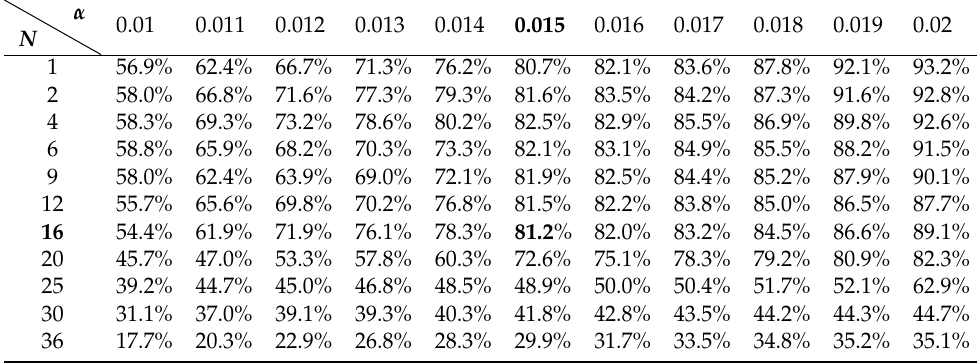
Table A2. The user accuracy with different α and N . The bold numbers indicate the best